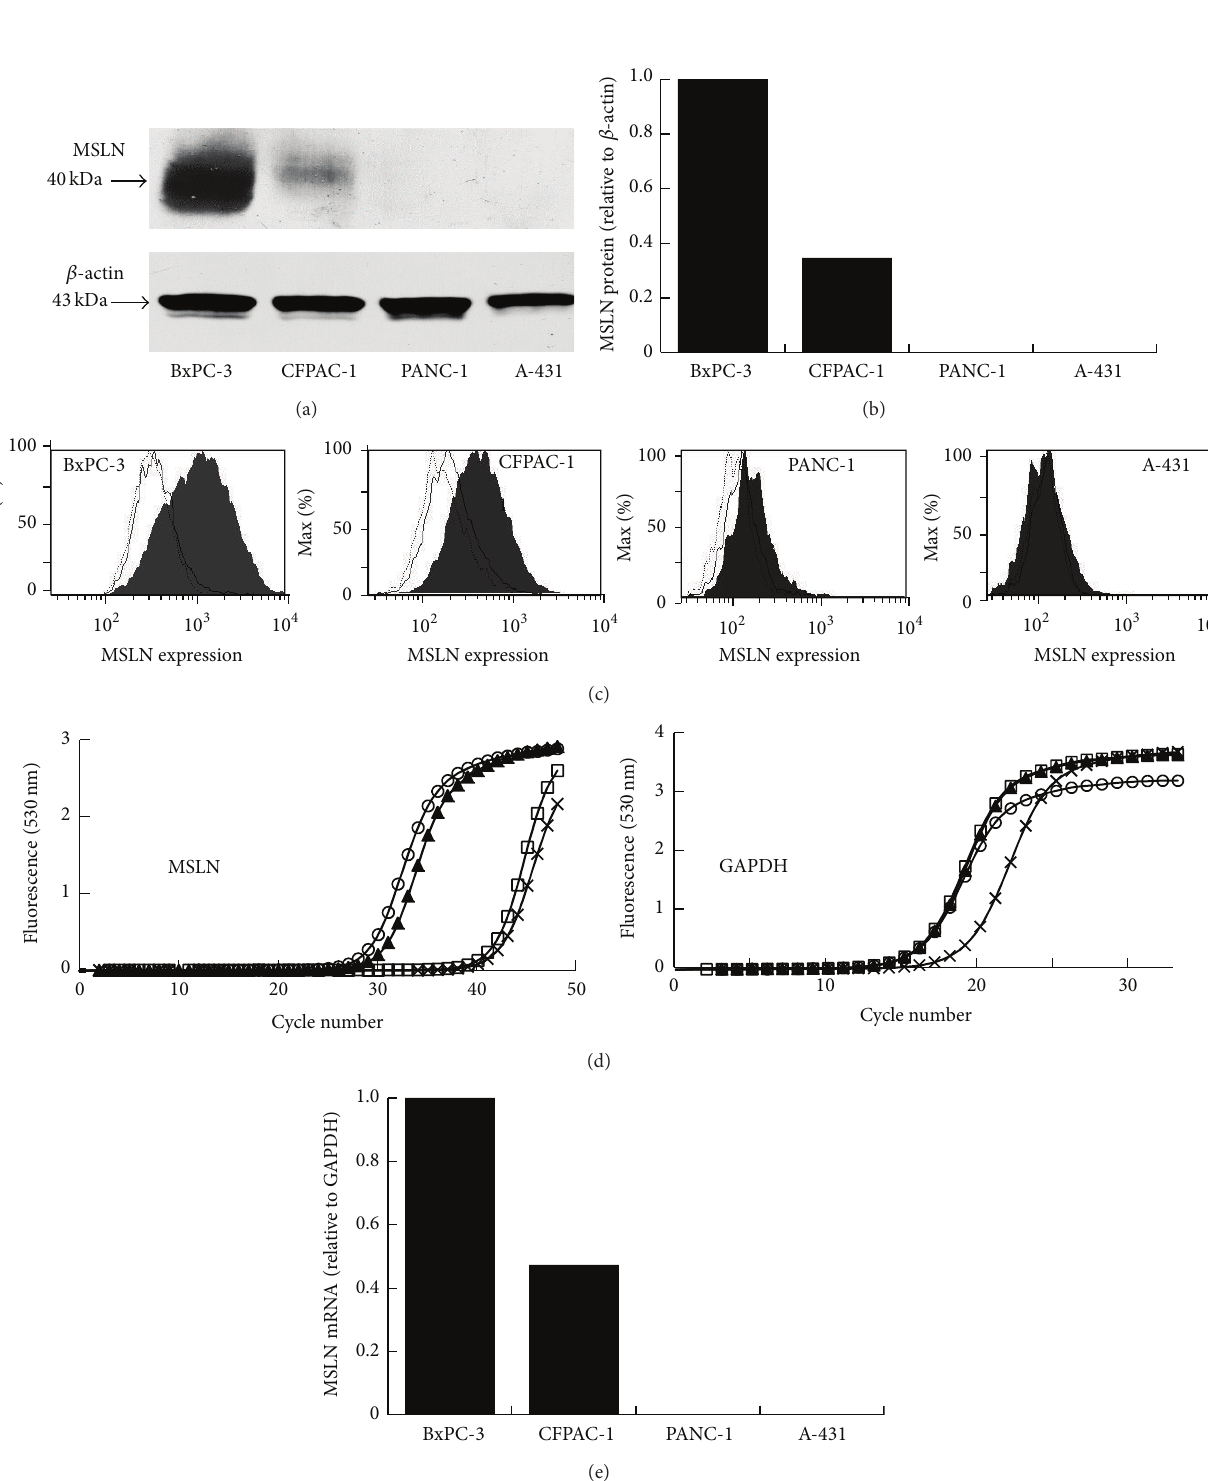
Figure 1: Analysis of MSLN protein expression in cancer cell lines by Western blot (a and b) and by flow cytometry using 11-25 mAb (b). 𝛽 -actin served as a loading control. Expression of MSLN mRNA in cultured BxPC-3 (open circles), CFPAC-1 (closed triangles), PANC-1 (open squares), and A-431 (x-marks) cells (d and